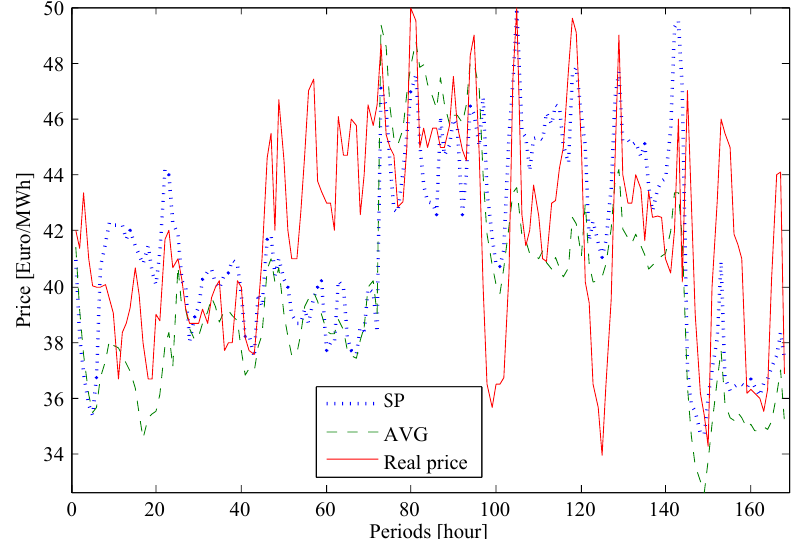
Figure 9. Prices of the SP model, average forecasted price (AVG) and real prices for the week of 4–10 June